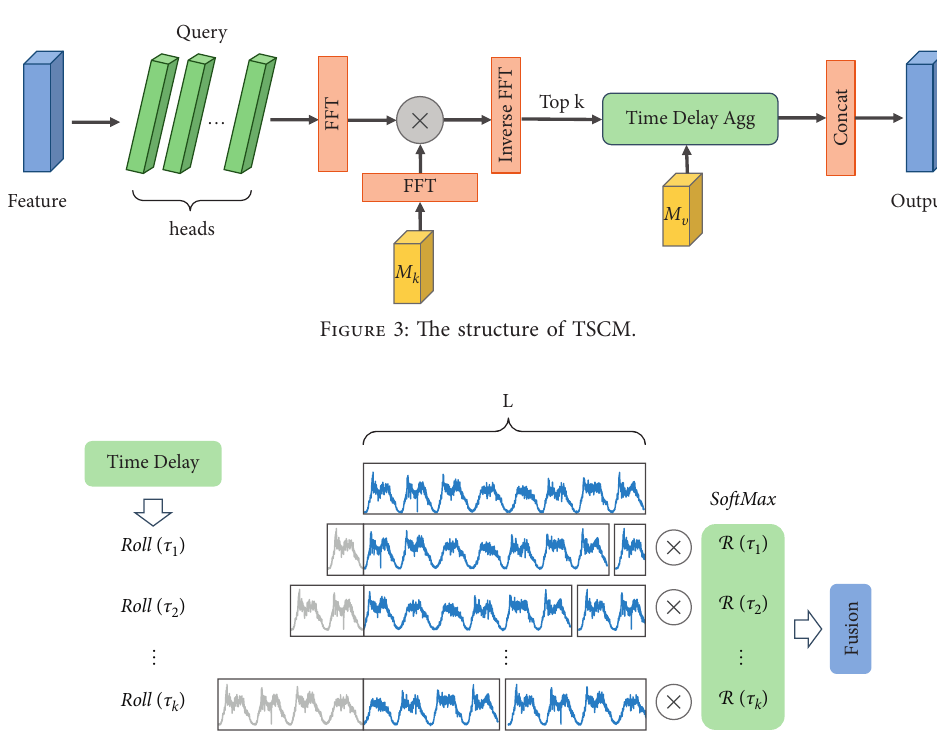
Figure 4: Time delay